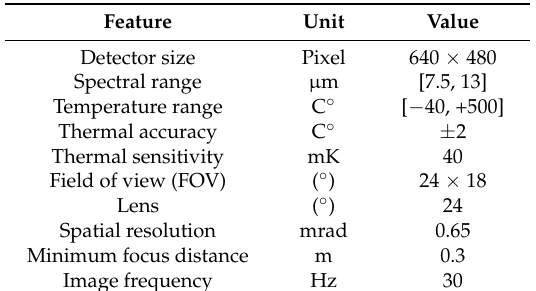
Figure 3. Examples of thermograms displaying thermal anomalies connected to slope instability phenomena in Italy. Dykelets and open fractures at Giglio Island, Tuscany (a-d); water seepage in sandstone layers (Fiesole, Tuscany) (e, f); aerial imaging of large landslide (San Benedetto Val di Sambro, Emilia Romagna) (g, h); unstable rock wall sector in (Val Nerina, Umbria) (i-m); debris apron along coastal cliff (Elba Island, Tuscany) (n,o).